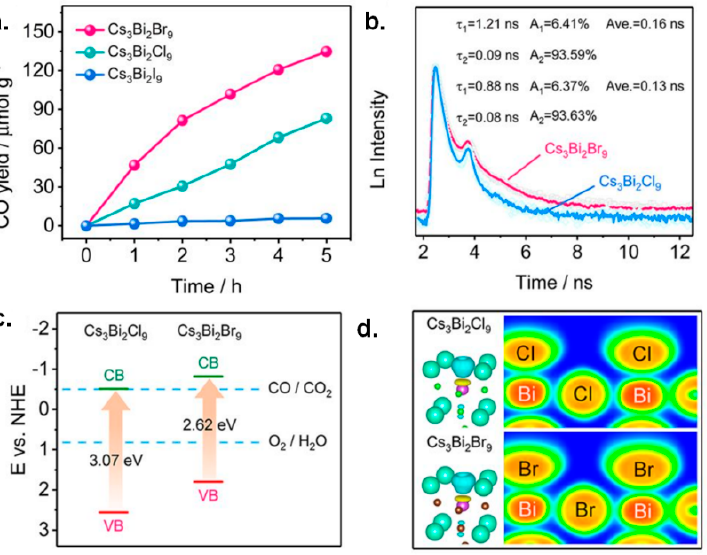
Figure 4. Investigation of the effect of different halogen ions in Cs 3 Bi 2 X 9 for CO production from CO2RR: ( a ) Time-dependent CO production, ( b ) Time-resolved fluorescence emission decay spec- tra, ( c ) Band structure, and ( d ) Charge difference distributions and electronic location function of Cs 3 Bi 2 Cl 9 and Cs 3 Bi 2 Br 9 . Adapted from [104].